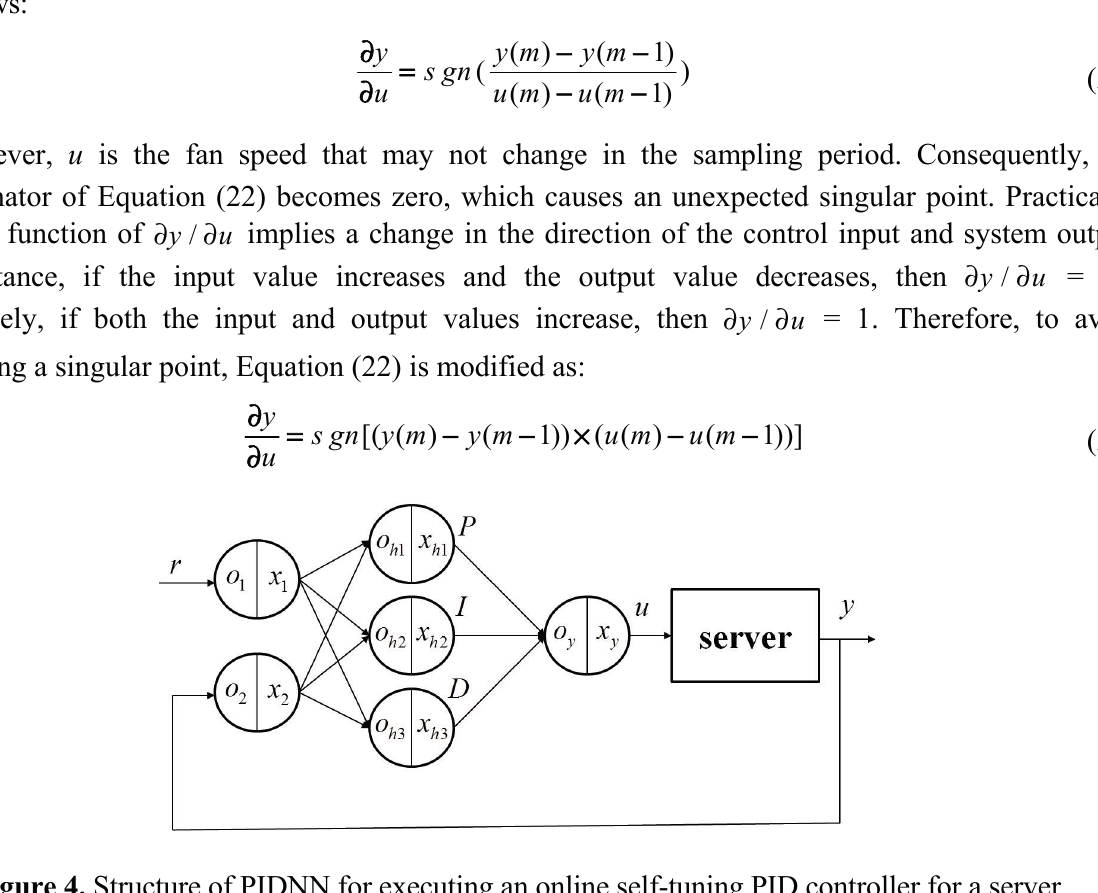
Figure 4. Structure of PIDNN for executing an online self-tuning PID controller for a